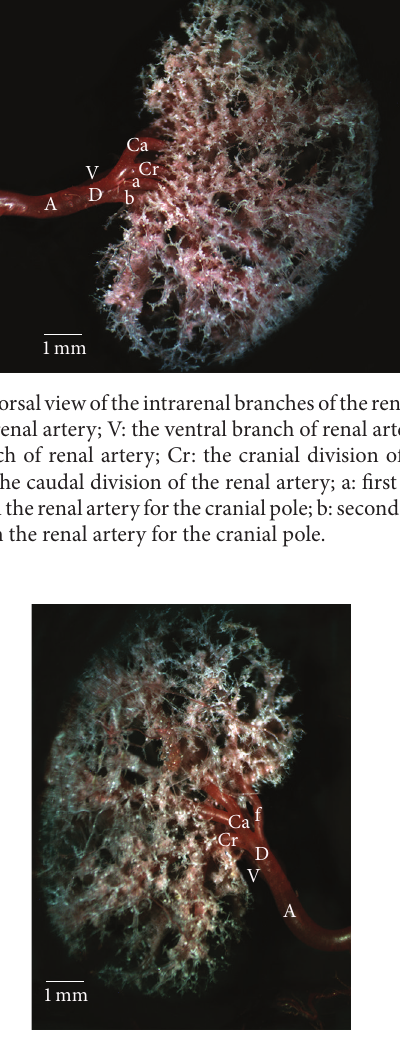
Figure5:Dorsalviewoftheintrarenalbranchesoftherenalarteries, Type Id. A: renal artery; V: the ventral branch of renal artery; D: the dorsal branch of renal artery; Cr: the cranial division of the renal artery; Ca: the caudal division of the renal artery; f: extrainterlobar branch from the renal artery for the caudal pole.